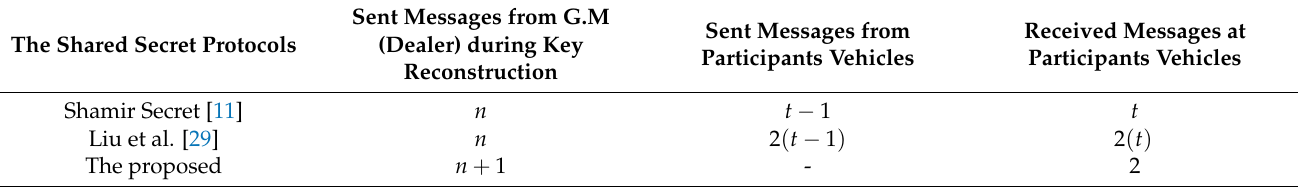
Table 7. The communication cost for the proposed protocol and some other related shared secret